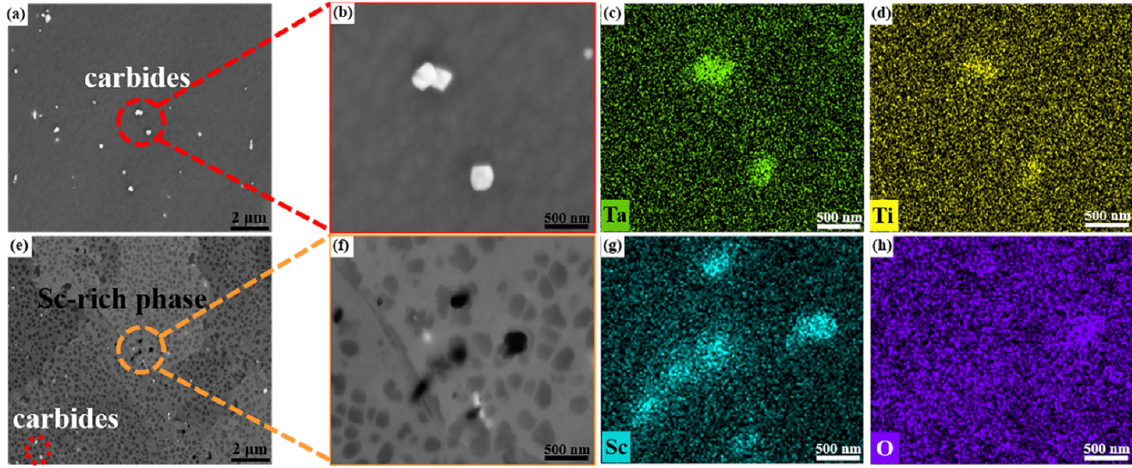
Figure 5. SEM image of Sc-doped RR1000 superalloy with relevant EDS analysis. ( a , b ) SE images of carbides in RR1000-0, ( c , d ) EDS analysis of carbides, ( e , f ) BSE images of Sc-rich phase in RR1000-0.064, ( g , h ) EDS analysis of Sc-rich phase.